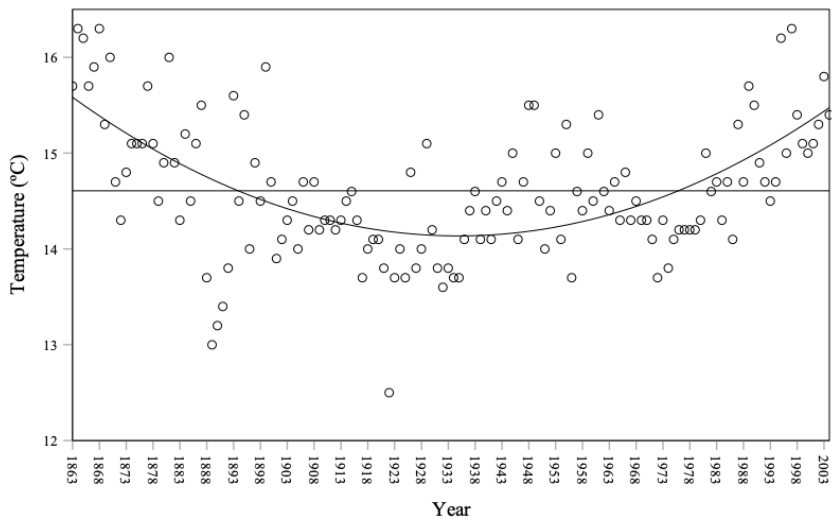
Figure 2. Projection of annual average temperatures for 1863–2004 (adapted from https://www.ipma.pt/pt/oclima/series.longas/list.jsp, accessed on 20 December 2021).